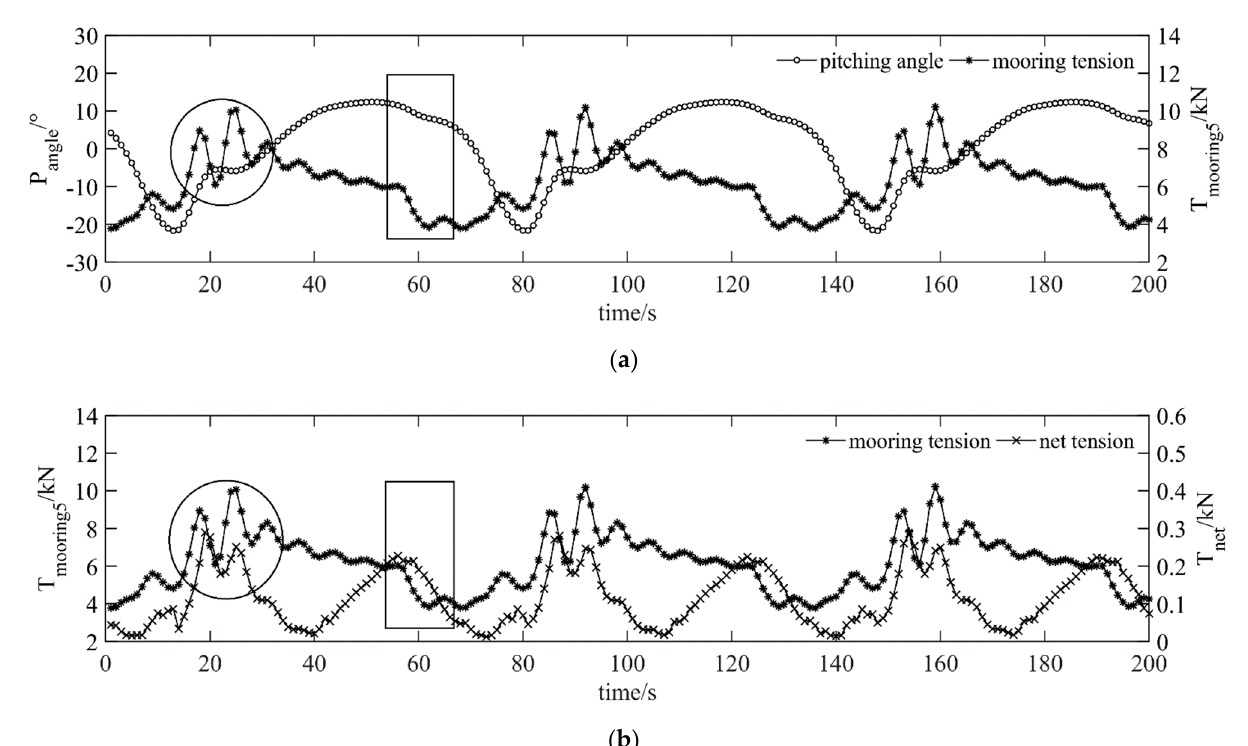
Figure 7. During curve of the pitching angle of floating reef, the tension of mooring rope, and total tension of fishing net’s tie points. ( a ) The relationship between the pitching angle of floating reef and the tension of mooring rope. ( b ) The relationship between the tension of mooring rope and total tension of fishing net’s tie points.